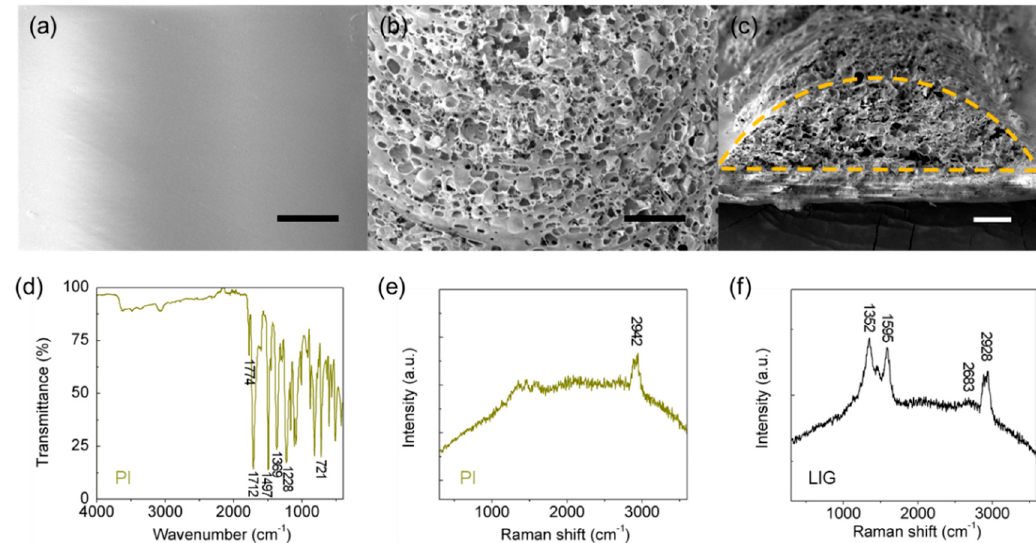
Figure 3. SEM images of ( a ) spin-coated PI film before LIG patterning. SEM images of ( b ) top view and ( c ) cross-sectional view of the on-film fabricated LIG. Scale bars: 20 μ m. ( d ) FT-IR spectroscopy result of the PI film. Raman spectroscopy results of ( e ) PI film and ( f ) LIG.